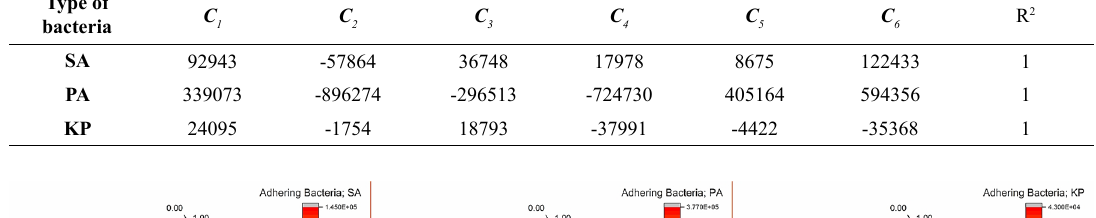
coefficients for the formula of Staphylococcus aureus (SA), Pseudomonas aeruginosa (PA), and Klebsiella Table 3. Values of the C i pneumonia (KP) Type of bacteria